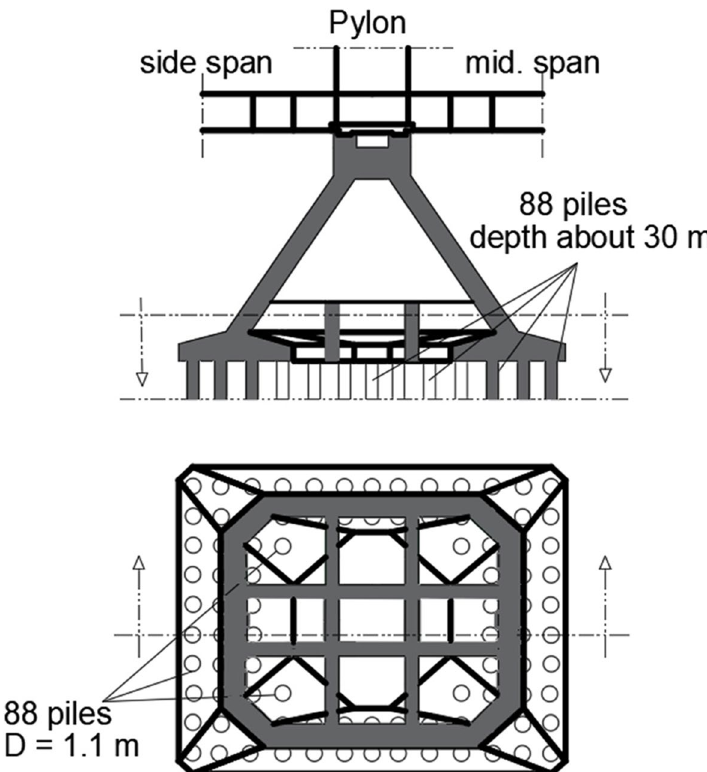
Fig. 3 General layout of piers on axis 7 and 8 and the pile